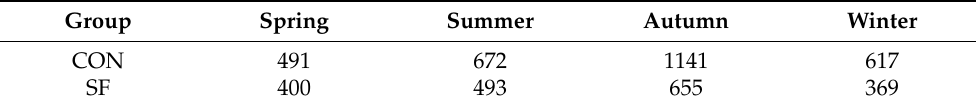
Figure 2. Effects of season and Suinfort ® in pig prolificacy (CON: Control; SF: Suinfort ® ). Estimated means (points) and their 95% confidence intervals (bars) for each treatment × season combination, for the numbers of total born ( a ), live-born ( b ), stillborn ( c ) and mummified ( d ) piglets in each farrowing. Table 2 shows the number of observations in each group (farrowed sows). The interactions between factors were not significant, and the effect of season was significant for all the variables (different letters a, b, indicate p ≤ 0.05 among seasons). There were no significant differences between CON and SF groups. Table 2. Sample size for the prolificacy study, grouped by treatment and season.